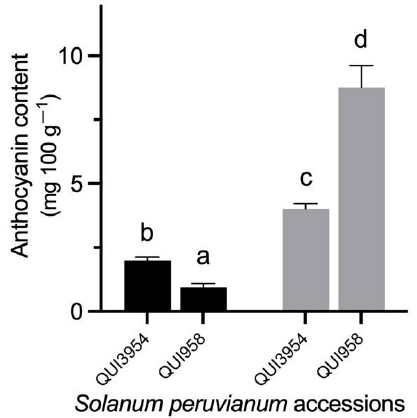
Figure 2. Anthocyanin content in the fruit peel of Solanum peruvianum QUI3954 and QUI958 accessions under drought stress. Samples from optimal- and restricted-watering plants are shown in black and grey bars, respectively. Content is expressed as mg of delphinidin 3-glucoside equivalent per 100 g of fruit peel. Error bars in each column indicate the standard deviation of three replicates. A Duncan’s multiple comparisons test was performed with 95% confidence. Different letters indicate significant differences between means. For details see the Section 2.